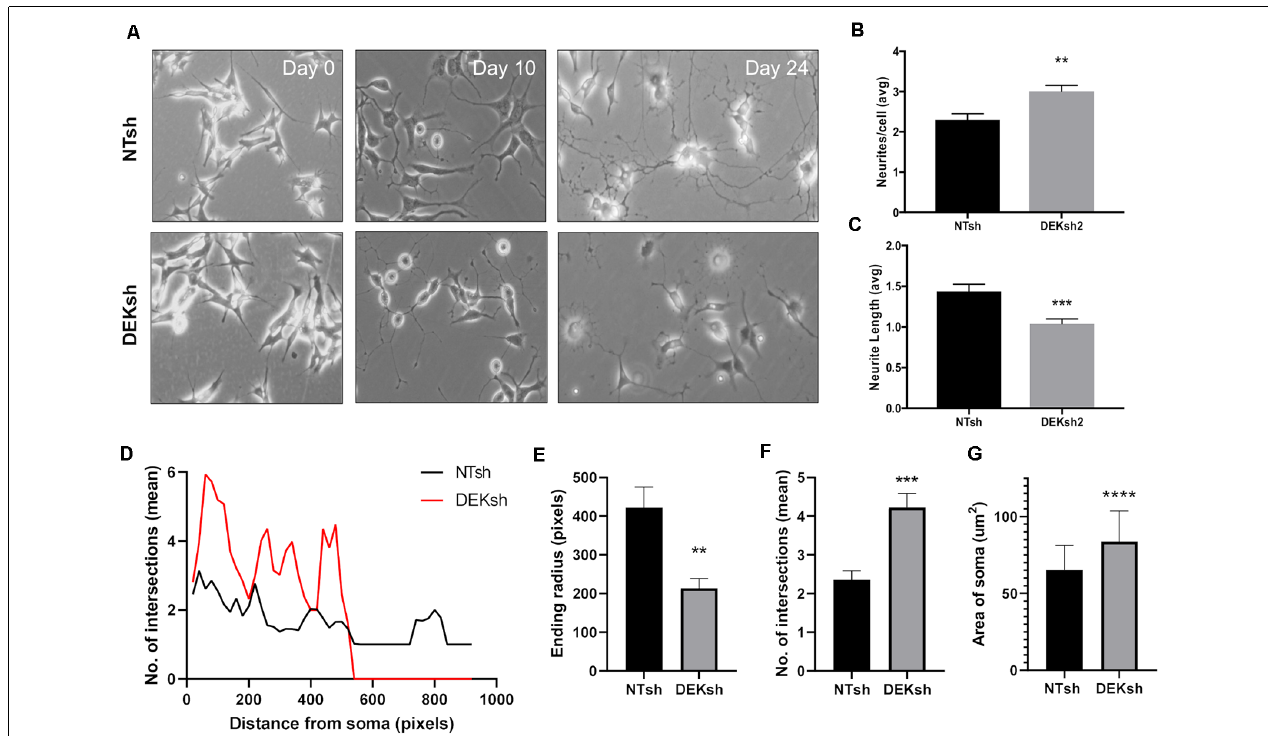
FIGURE 2 | DEK loss impairs neurite formation in differentiated cells. (A) Representative images from the progression of SH-SY5Y cells into differentiated neurons. (B) Quantification of the number of neurites per cell in (A) . DEKsh had significantly more neurites per cell (** p < 0.01), but (C) the neurites from DEKsh cells were shorter in length (*** p < 0.001). (D) Sholl analysis results represent the number of intersections between neurites and radii projecting from the focal point (center of cell body) generated by Simple Neurite Tracer Sholl analysis in ImageJ. (E) According to Sholl analysis, neurites on DEKsh cells were significantly shorter than NTsh (** p < 0.01). (F) Quantification of the mean number of intersections shows increased intersections for DEKsh cells compared to controls, as determined by Sholl analysis (*** p < 0.001). (G) The cell body (soma) sizes of DEKsh cells were significantly greater than NTsh (**** p <